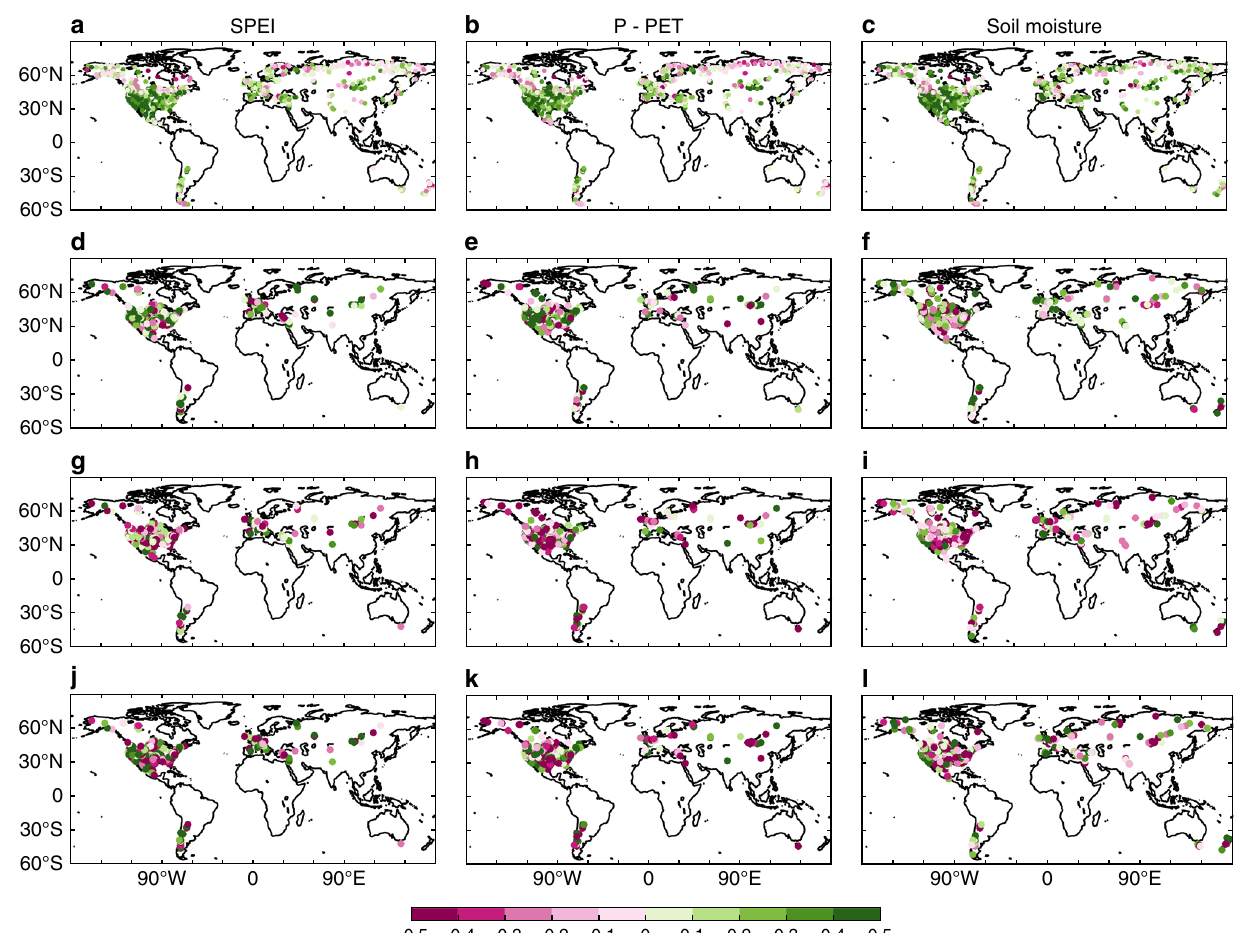
Fig. 2 Spatial distribution of tree radial growth change after extreme climate events. Spatial pattern of Pearson ’ s correlation coef fi cients between tree-ring width and SPEI a , P − PET b , and soil moisture c . Enhanced growth after extreme wetness, reduced growth after extreme drought, and compensation using the SPEI d , g , j , P − PET e , h , k , and soil moisture f , i , l , summed over the fi rst 5 years after extreme wet/drought years, where the tree-ring chronologies are signi fi cantly and positively correlated with the climate indices. Maps were created using Matlab R2015b. P − PET: precipitation minus potential evapotranspiration, SPEI: Standardized Precipitation-Evapotranspiration